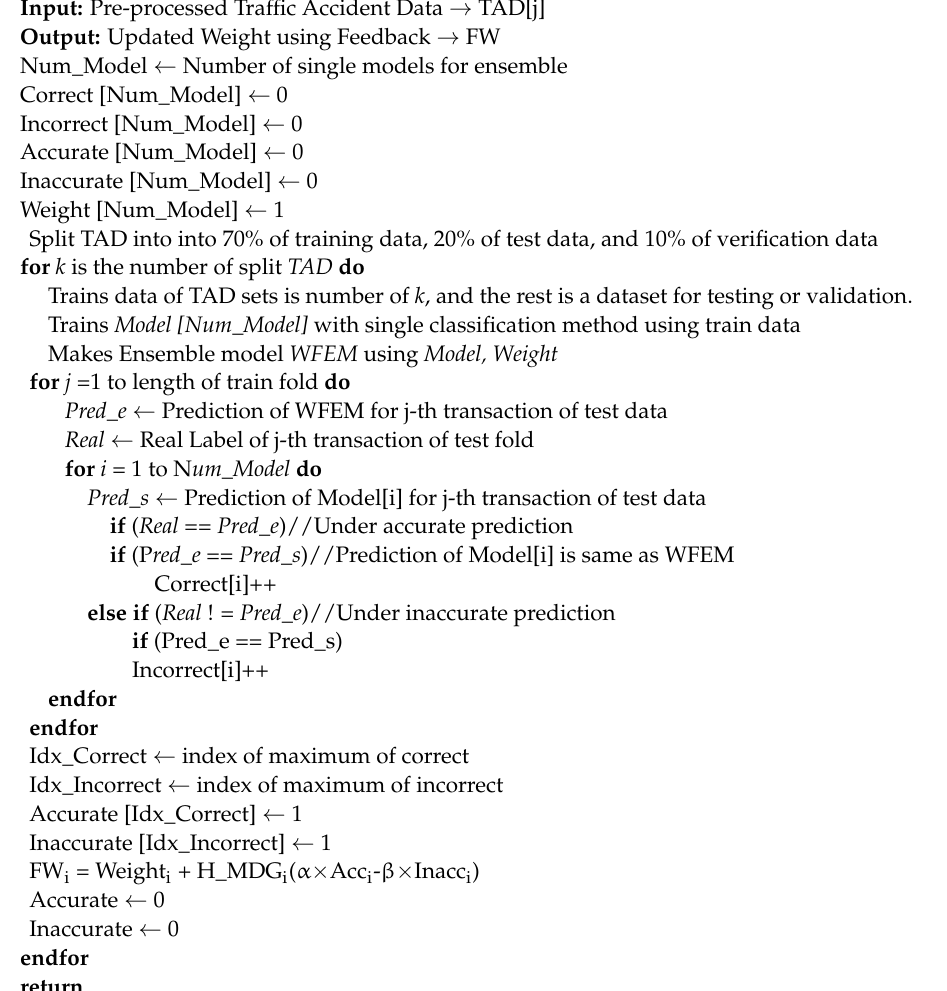
Algorithm 1. Weight feedback based harmonic MDG-ensemble